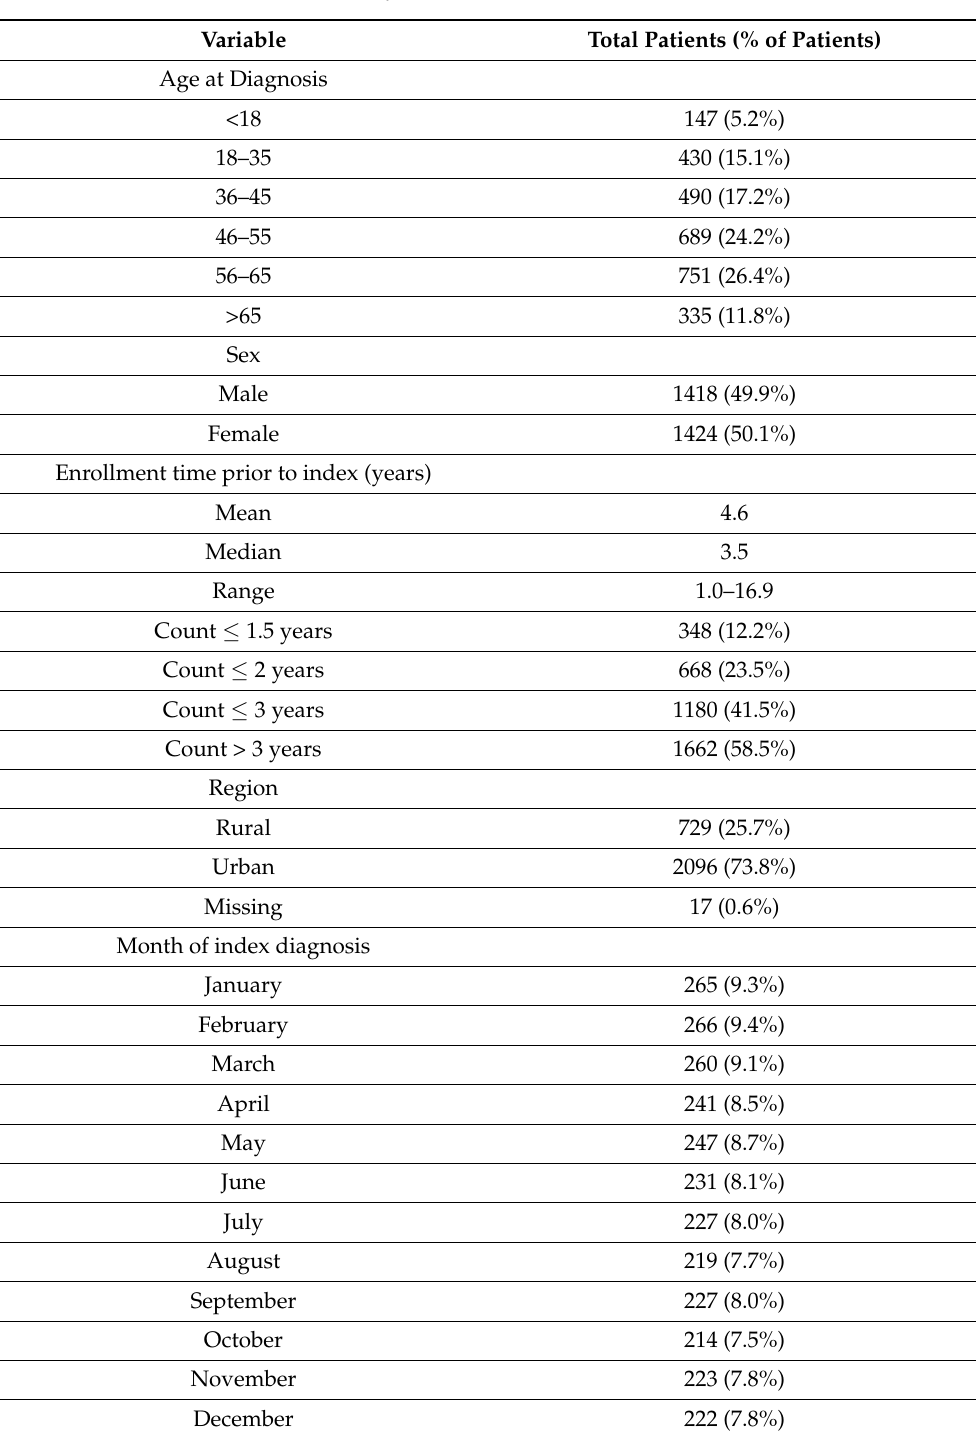
Table 1. Baseline characteristics of study